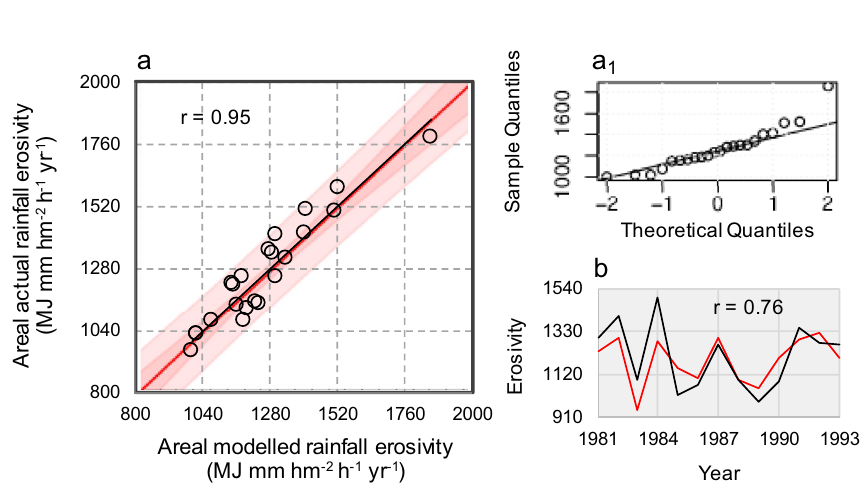
Figure 3. Model calibration and validation. ( a ) Scatterplot of regression model (black line, Eq. (1) and red line of identity) vs. actual rainfall erosivity estimated upon the MedCA over the period 1994–2015, with the inner bounds showing 90% confidence limits (power pink coloured area), and the outer bounds showing 95% prediction limits for new observations (light pink). ( a 1 ) related QQ-plot of residuals at calibration stage. ( b ) Time co-evolution (1981–1993) of actual (black curve) and estimated (red curve) of rainfall erosivity at validation stage (in a , b , r stands for linear correlation